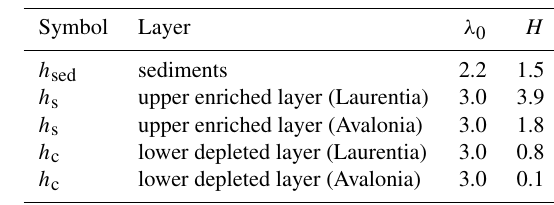
Table 1. Thermal properties assigned to each layer in the British Isles, summarized from Mather et al. (2018). Units of λ 0 are Wm − 1 K − 1 and H are µWm − 3